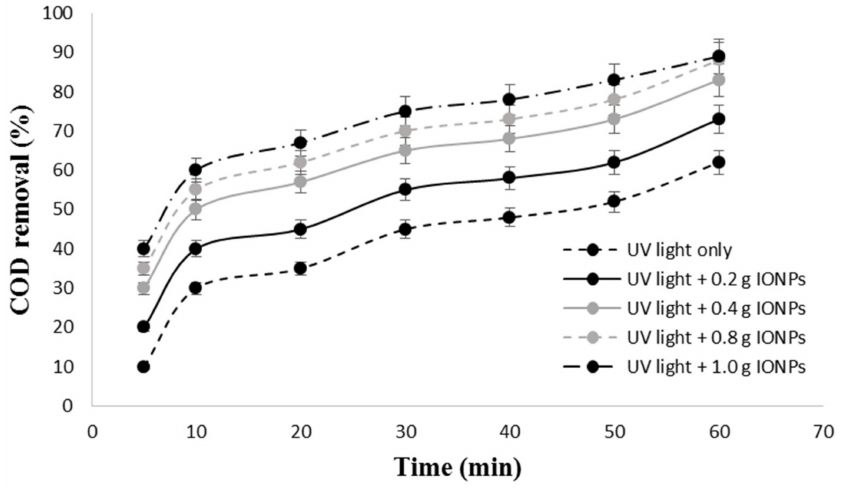
Figure 5. Effect of time and iron oxide nanoparticles dosage on COD removal from synthetic petroleum